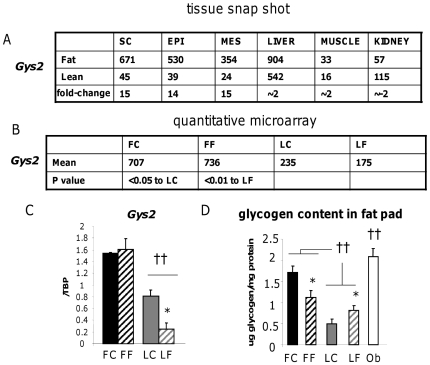
Validation and functional investigation of the non-QTL linked, obesity-associated gene Gys2.
A. Snap-shot pooled transcriptome microarray chip intensities (arbitrary units) across subcutaneous (SC), epididymal (EPI), mesenteric (MES) adipose tissues versus liver, muscle and kidney in Fat (F) and Lean (L) mice with the rounded expression ratio in bold. B. Mean chip intensity from quantitative microarray (n = 4) in Fat and Lean mice fed control (FC, LC) or high fat diets (FF, LF) with relevant P value for significant differences. C. RT-PCR validation of changes in Gys2 gene expression in subcutaneous adipose tissue of control diet-fed Fat (FC, black bars), high fat diet-fed Fat (FF, black hatched bars), control diet-fed Lean (LC, grey bars) and high fat diet-fed Lean (LF, grey hatched bars) mice. †† = P<0.01 difference between F and L lines, * = P<0.05 indicates and effect of diet within the L line. D. Glycogen content of fat pads in subcutaneous adipose tissue of control diet-fed Fat (FC), high fat diet-fed Fat (FF), control diet-fed Lean (LC) and high fat diet-fed Lean (LF) mice and in genetically-obese leptin-deficient Lepob (Ob, white bars) mice. †† = P<0.01 difference between F or Ob versus and L mice and * = P<0.05 indicates and effect of diet within Fat or Lean lines.